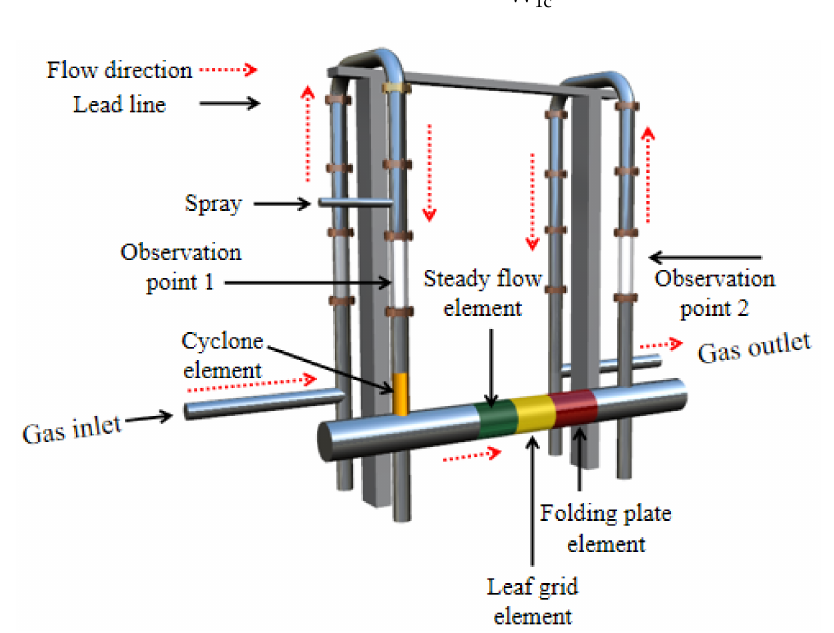
Figure 2. Experimental schematic.